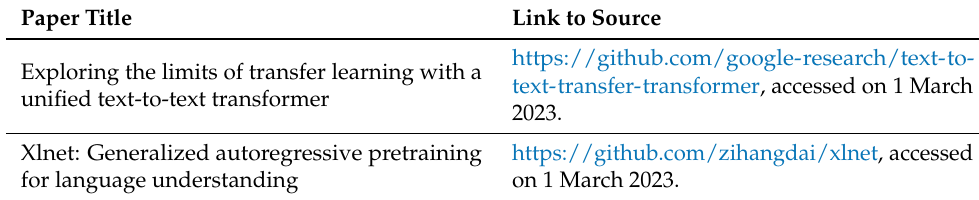
Table 7. Source code links for Sentiment Analysis.